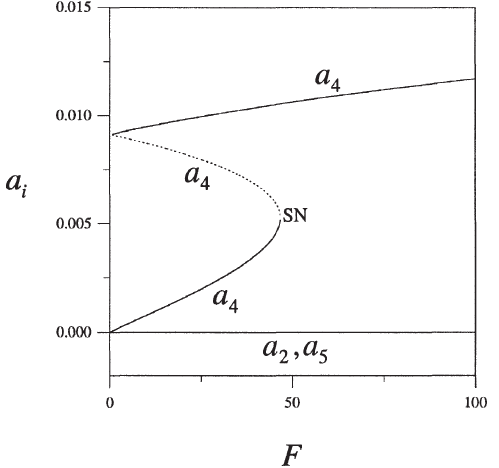
Fig. 4. Amplitude-response curves for the case (cid:10) (cid:25) ! 4 (cid:25) 1 ( ! 2 + ! 5 ) when (cid:27) 1 = 10, (cid:27) 2 = (cid:0) 10, (cid:22) 2 = 0 : 0635, (cid:22) 4 = 0 : 0573, and (cid:22) 5 = 0 : 0400. 2 Solid lines (—) denote stable fixed points and dotted lines ( (cid:1)(cid:1)(cid:1) ) denote unstable fixed points. SN denotes a saddle-node bifurcation.